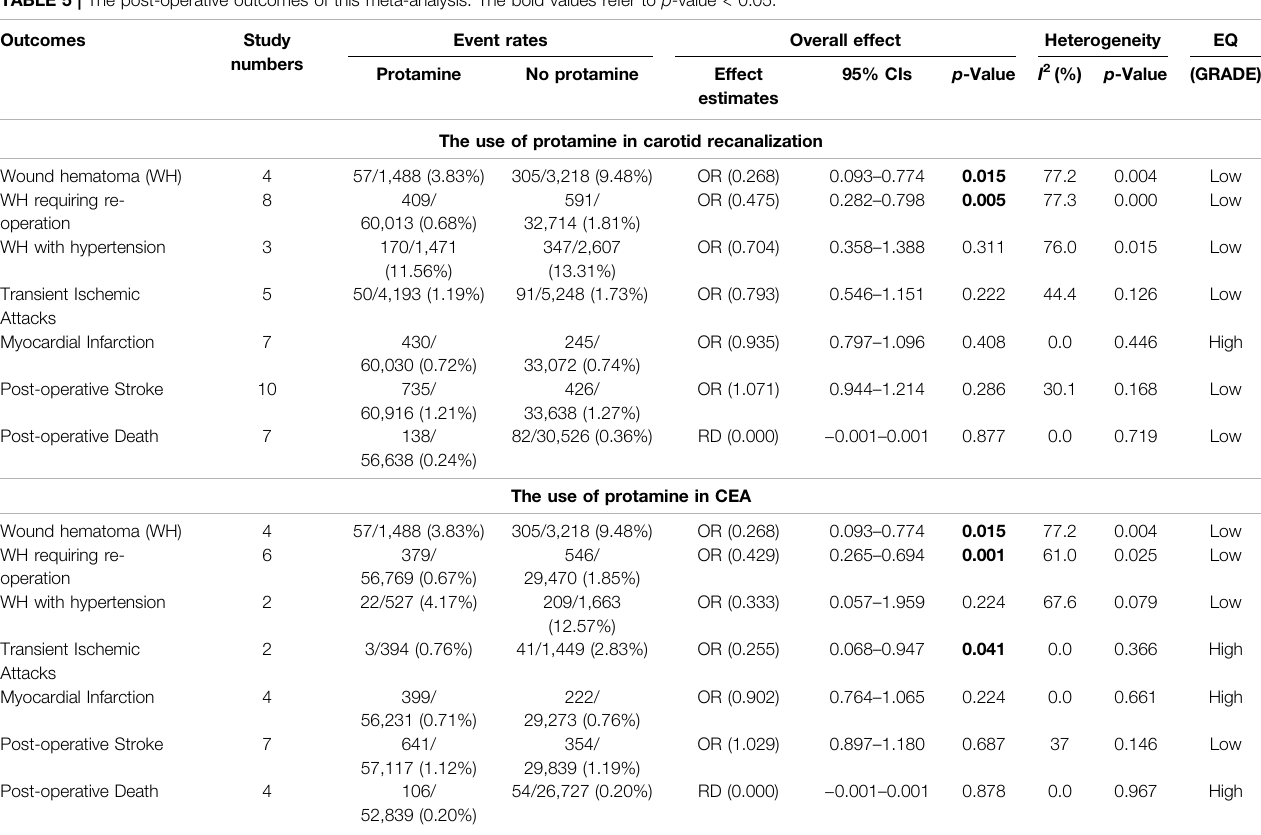
TABLE 5 | The post-operative outcomes of this meta-analysis. The bold values refer to p -value <